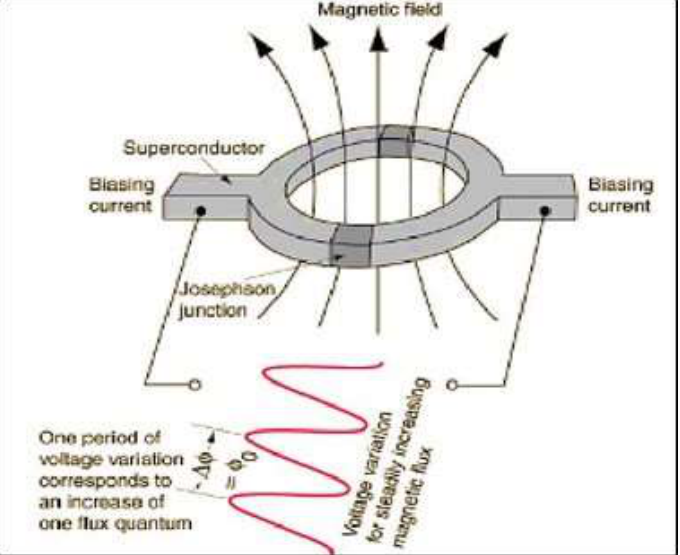
Figure 9: the schematic architecture of a SQUID sensor's core element